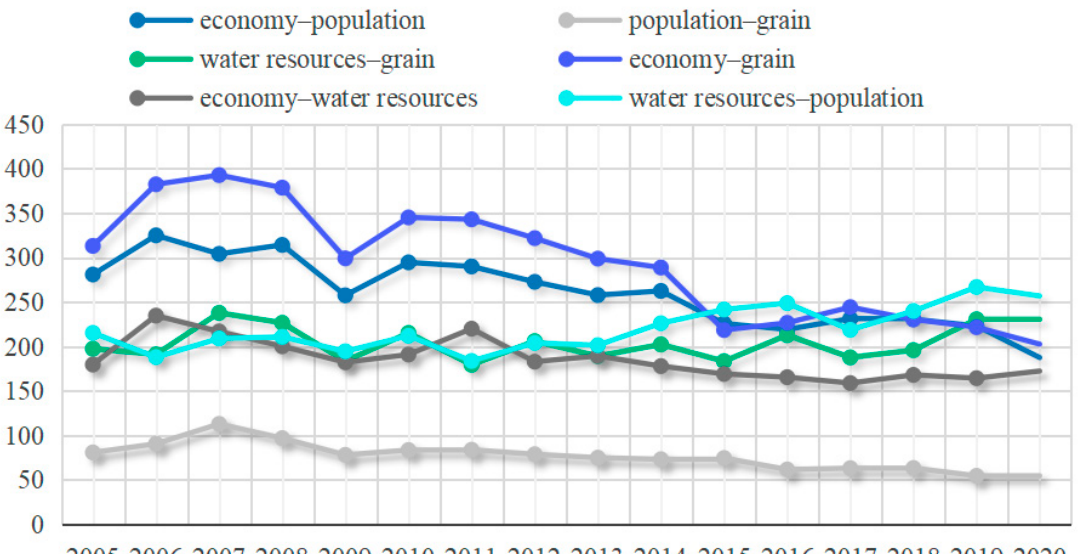
Figure 10. Spatial overlap of two elements in the Tarim River Basin.